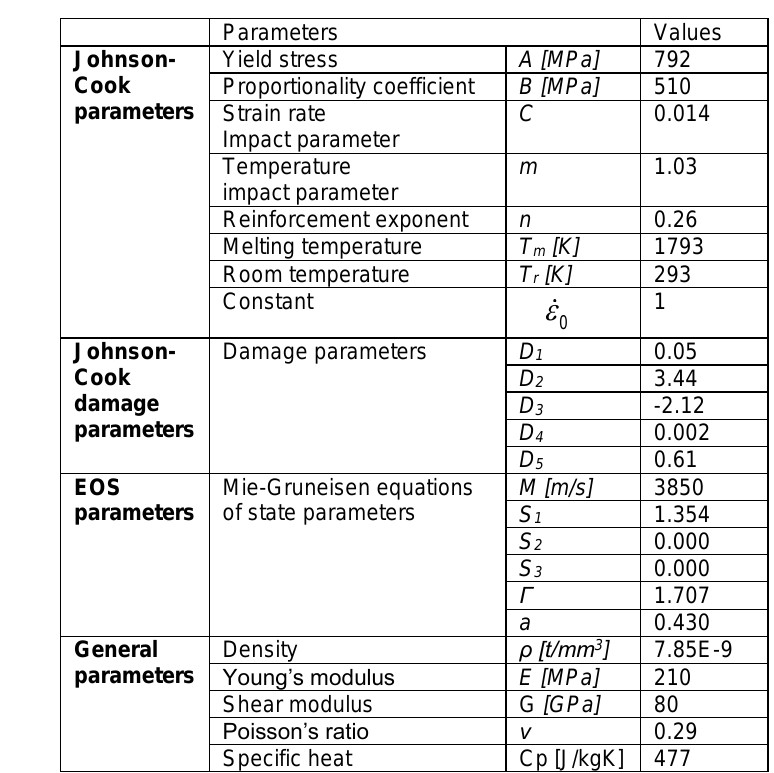
Table 3 – Material characteristics of the armor plate for the explicit dynamic analysis Таблица 3 – Характеристики материала бронелиста и характеристики